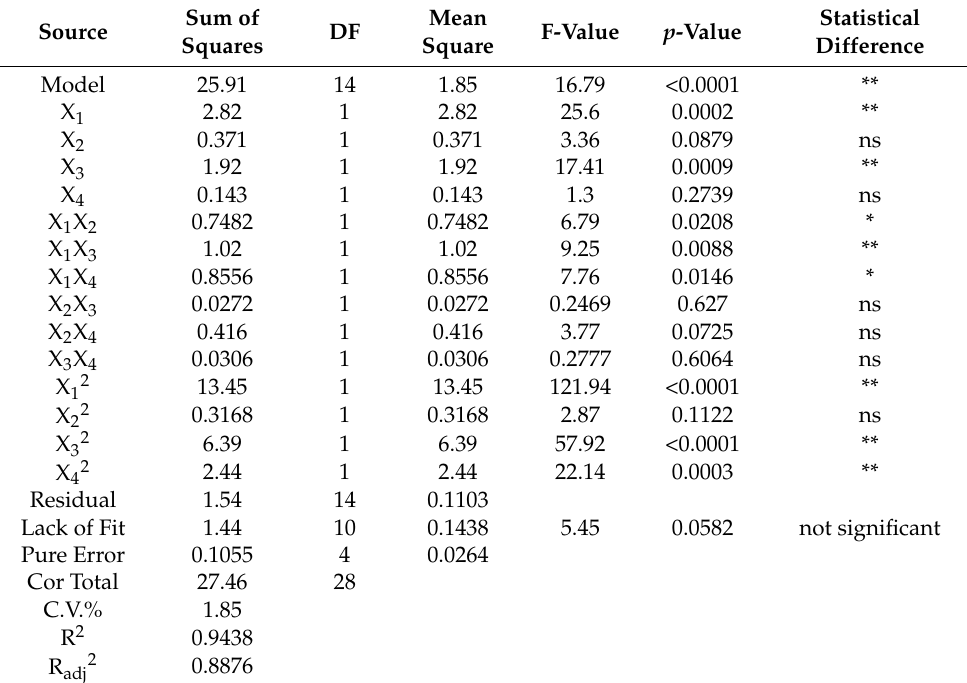
Table 2. Response Surface Quadratic Model Variance Analysis and regression coefficient. Sum of Source Squares